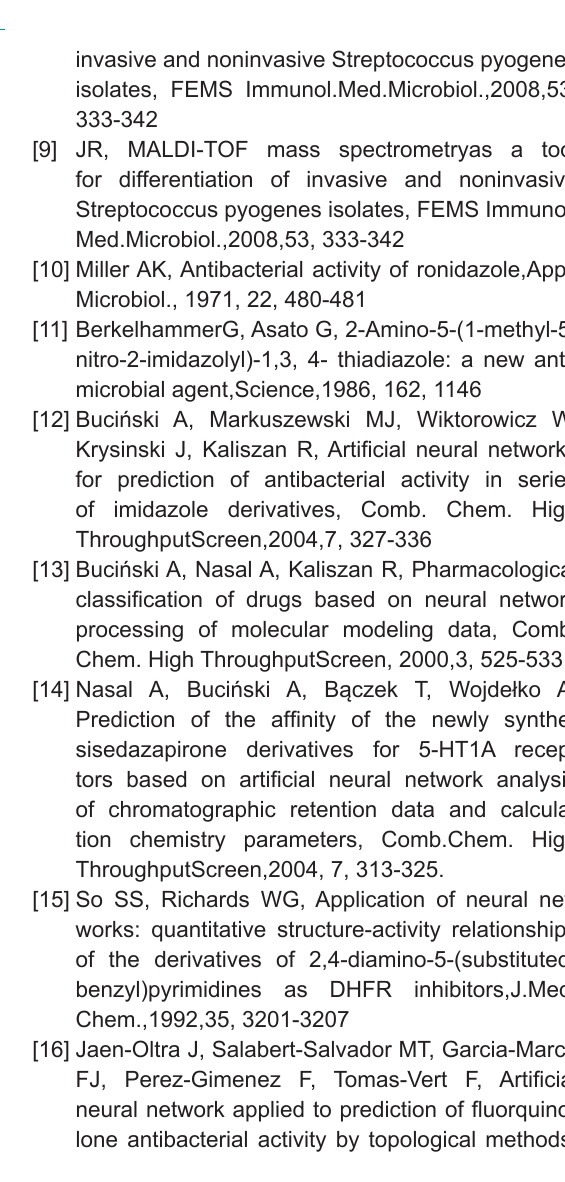
(1- 236 imidazole rings Fig. 1a; 237-286 benzimidazole rings Fig.2b) (Str 7 – Difference between experimental and predicted log 1/MIC values. L – Learing set, V – Validation set, T – Testing